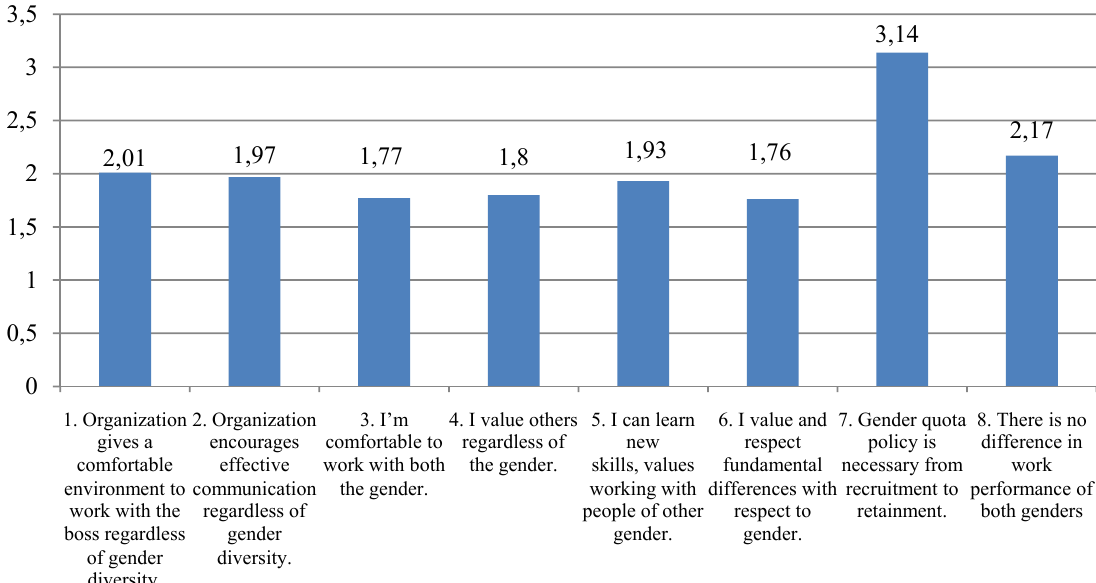
Fig. 1. Acceptance of gender diversity